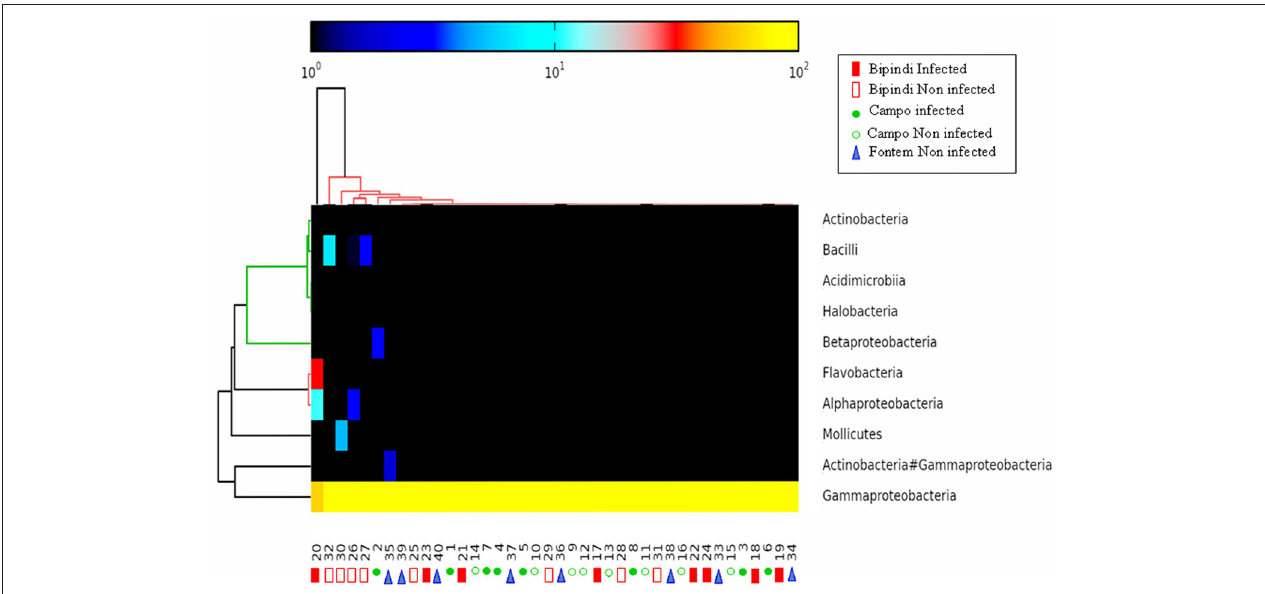
FIGURE 5 | Heat map analysis of the distribution and abundance of the bacterial classes in midgut samples. The samples did not cluster together, indicating highly variable bacterial communities. Sample numbering as in Figure 4